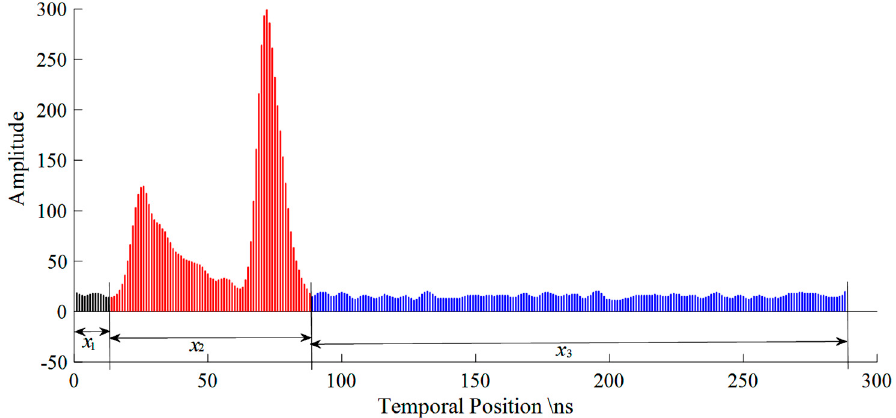
Figure 3. Waveform segmentation and selection of effective parts.